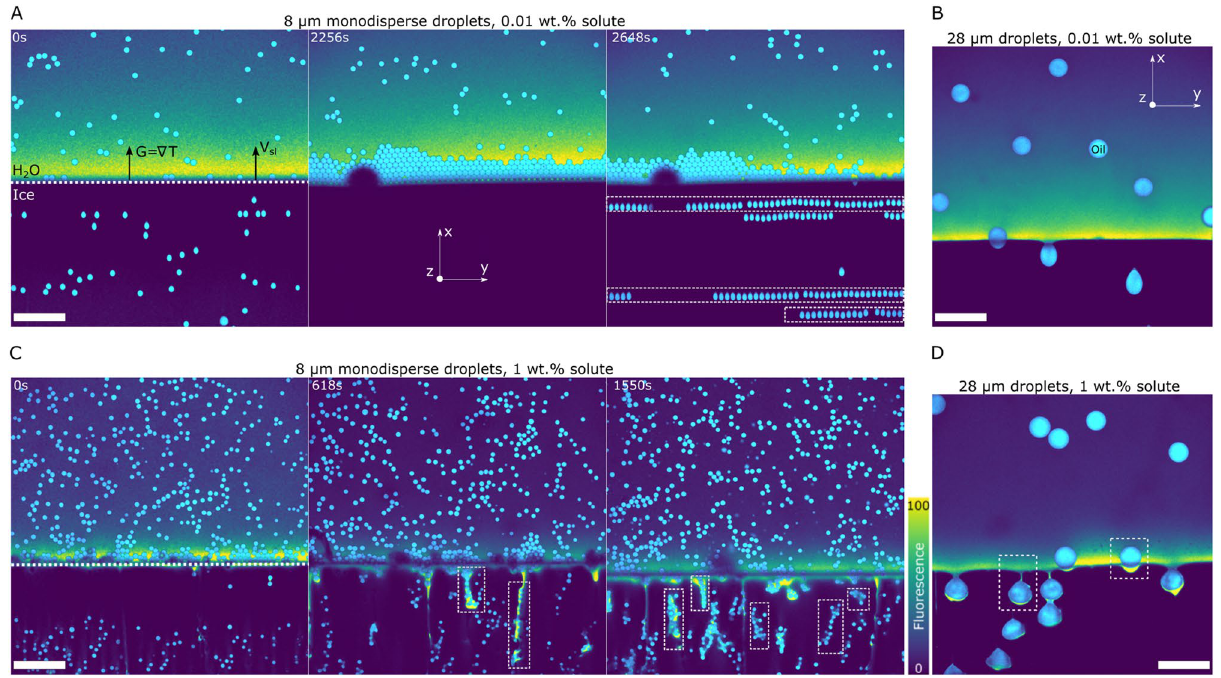
Figure 5. Interaction of monodisperse oil droplets with an advancing ice-water front. Solidification induced features and spatial distribution of oil droplets depicting ( A ) Horizontal mono-layers and stable planar front with 8 µ m ( R 1 ) at 0.01 wt.% solute. The semi-circular dark shape is a bubble that happened to be present in this particular experiment. As it does not fluoresce, it appears dark in the experiment. The bubble in this case has no impact on the stability of the front. ( B ) No clusters and stable planar front with 28 µ m ( R 2 ) at 0.01 wt.% solute, ( C ) Vertically aligned clusters and local front destabilisation with 8 µ m ( R 1 ) at 1 wt.% solute, and ( D ) Rejected solute segregation and local front destabilisation from solute premelted films with 28 µ m ( R 2 ) at 1 wt.% solute. Oil is in cyan, water in colormap viridis (fluorescence bar) while ice is in black. Scale bar = 100 µ m . © (2020) S. Tyagi et al. (10.6084/m9.figshare.13176221) CC BY 4.0 license https ://creat iveco mmons .org/licen low growth velocities ( V sl ≤ 5 µ m · s − 1 ) for small solute concentrations ( ≤ 10 − 1 wt.%). As we increase the front velocity or the solute concentration, the steady state planar front develops local growth instabilities with a few cells boundaries, which remain stable during experimental time scales ≈ 40 − 60min . At the higher velocities and solute concentrations, the front eventually destabilises into a cellular front morphology. The uniformly spaced lamellae are generated owing to the propagation of a Mullins-Sekerka instability during the solid–liquid phase transformation 44 .